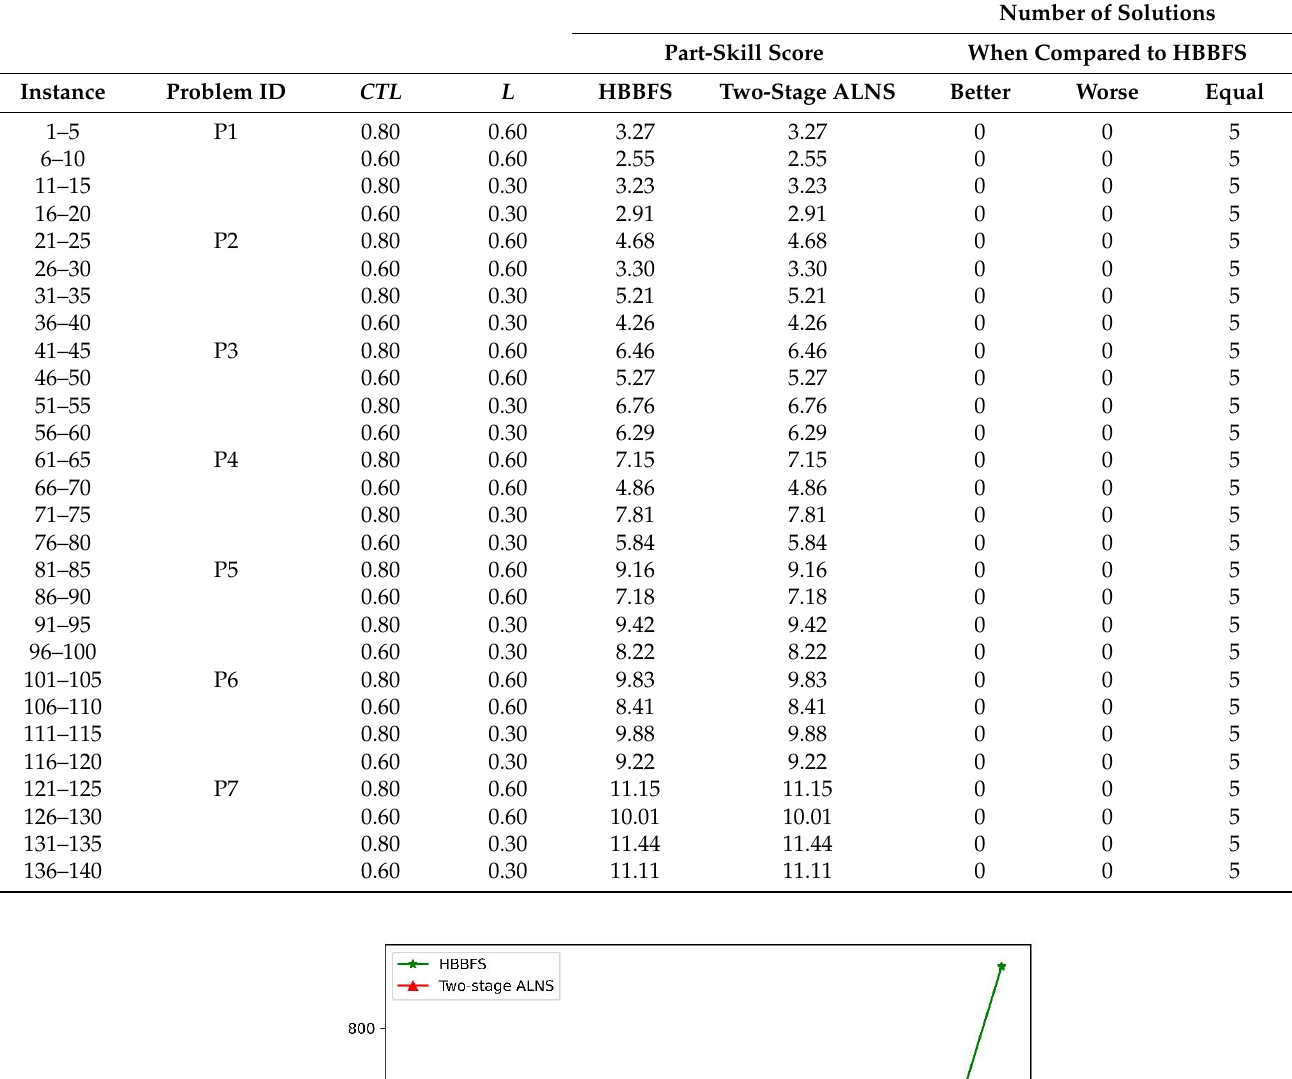
Table 16. Comparison of two-stage ALNS and HBBFS methods on 140 small-sized instances.